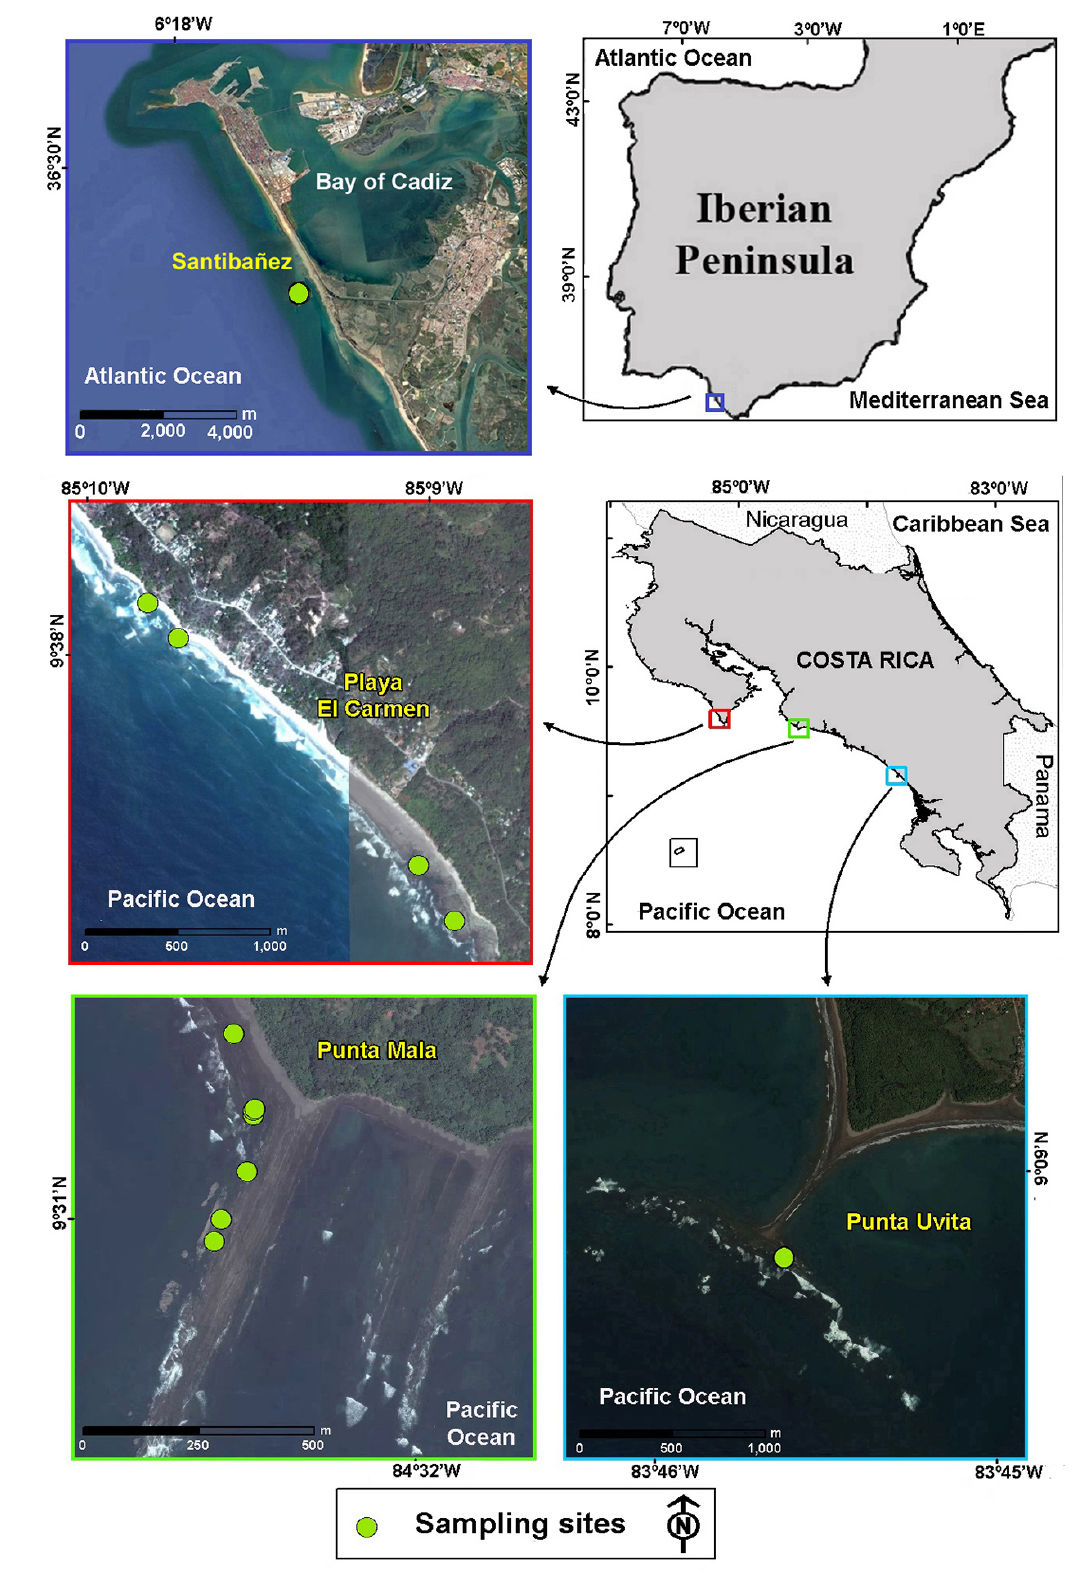
Figure 2. Sampling sites of hermit crabs collected in Spain ( Clibanarius erythropus ) and on the Pacific coast of Costa Rica ( Clibanarius albidigitus , Calcinus obscurus, Paguristes sp. (Images from Google Earth, v. 7.3.0.3832